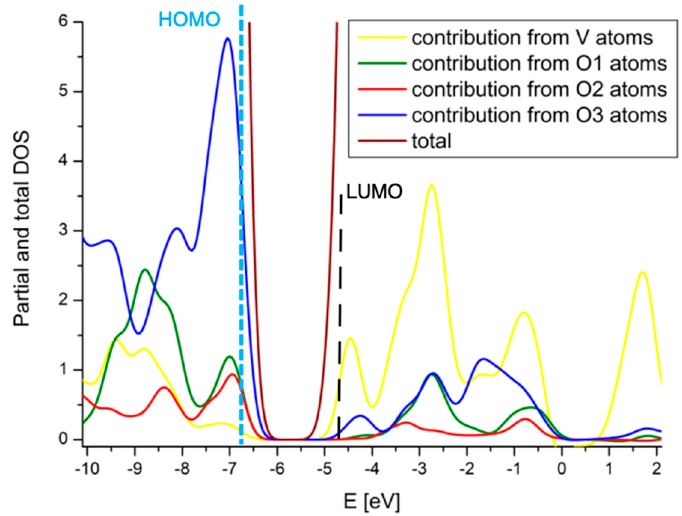
Figure 10. Simulated DOS plot of V 2 O 5 .